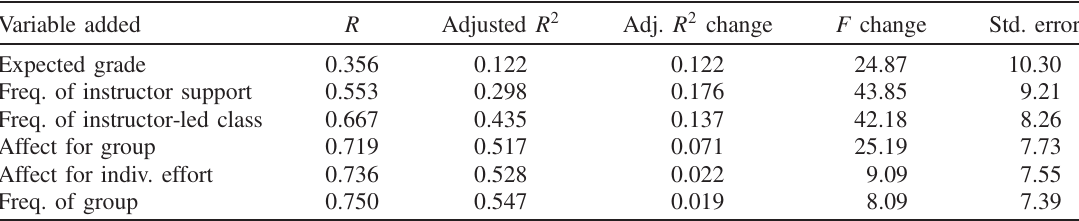
TABLE VII. Experiential and affective variables regressed against course satisfaction ( N ¼ 173 ). The improve- ment to adjusted R 2 is shown for the addition of each variable. Each variable made a significant ( p < 0 . 01 ) contribution to the